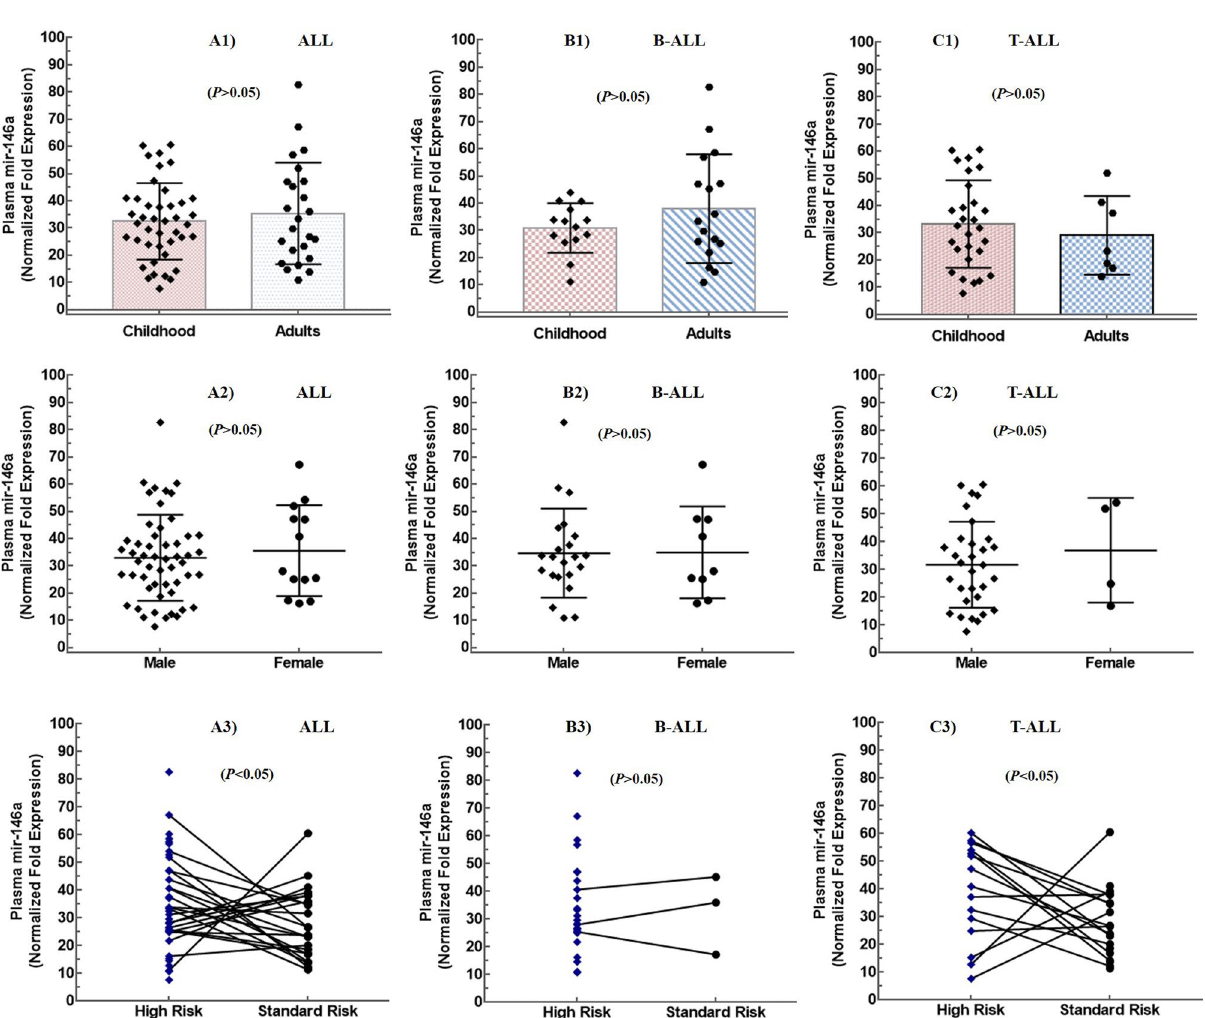
Figure 2. Association of plasma mir-146a expression with age, gender and risk status. Normalized fold expression of mir-146a in childhood and adult patients in ( A1 ) ALL, ( B1 ) B-ALL, ( C1 ) T-ALL. Scatter plots represented no significant difference in mir-146a expression levels in childhood compared with adults. There were no gender differences in mir-146a expression in plasma of ( A2 ) ALL, ( B2 ) B-ALL, ( C2 ) T-ALL. Fold expression of mir-146a was significantly increased in high risk groups compared with standard risk in ( A3 ) ALL and ( C3 ) T-ALL, however, no significant difference was observed in ( B3 )